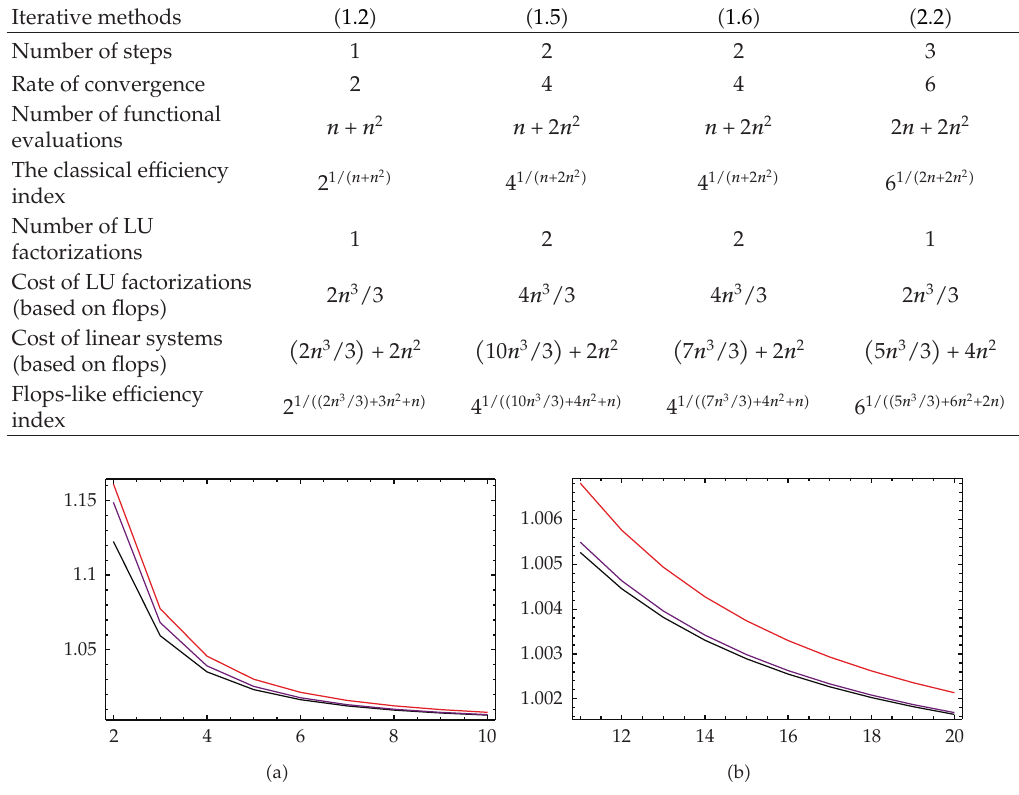
Figure 1: The plot of the (cid:2) traditional (cid:3) e ffi ciency indices for di ff erent methods (cid:2)(cid:2) a (cid:3) , for n (cid:4) 2 ,..., 10 and (cid:2) b (cid:3) , for n (cid:4) 11 ,..., 20 (cid:3)